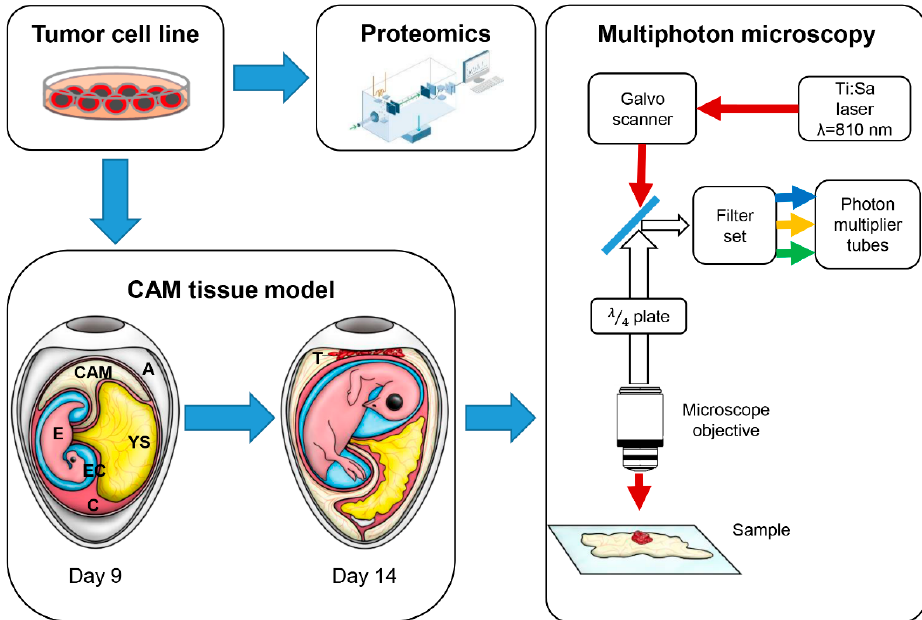
Figure 1. Schematic representation of the experimental study to analyze proteomics as well as the ECM remodeling potential of tumor cells. Tumor cell lines harboring a specific gene ko were investigated by proteomics in order to study the DAPK1-dependent proteomic signature. Tumor cells were embedded onto the CAM of a fertilized hen egg and finally imaged using multiphoton microscopy. First, deep-red fluorescence-labeled and Matrigel-embedded tumor cells were transplanted onto the CAM (CAM model: CAM: chorioallantoic membrane; A: albumen; E: embryo; EC: embryotic cavity; YS: yolk sack; C: chorion; T: tumor). After 5 days, CAM tumors were prepared and subsequently analyzed using an upright multiphoton microscope. A quarter-wave plate was integrated to ensure equal SHG signal intensities across different spatial polarization orientations.